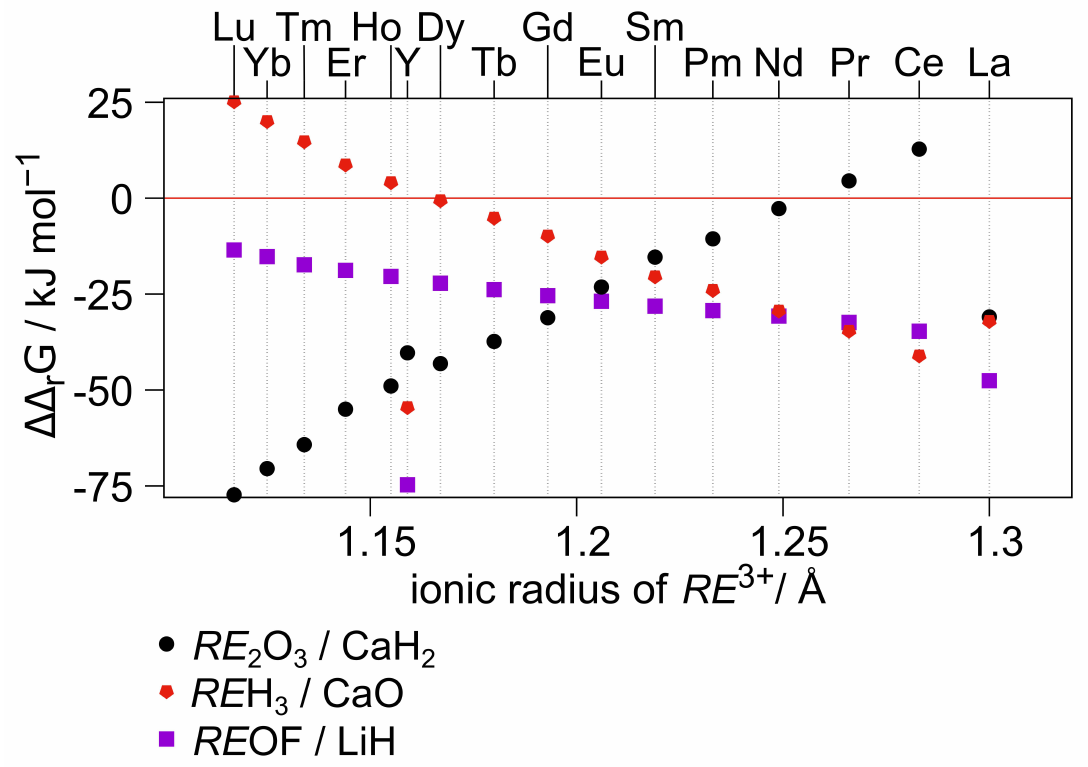
Figure 9. Differences of the free reaction enthalpies ∆∆ r G of the three RE HO synthesis approaches using alkaline and alkaline earth compounds and their respective side reactions against the ionic radii of eightfold coordinated RE 3+ ions [64]. Negative values: formation of RE HO is